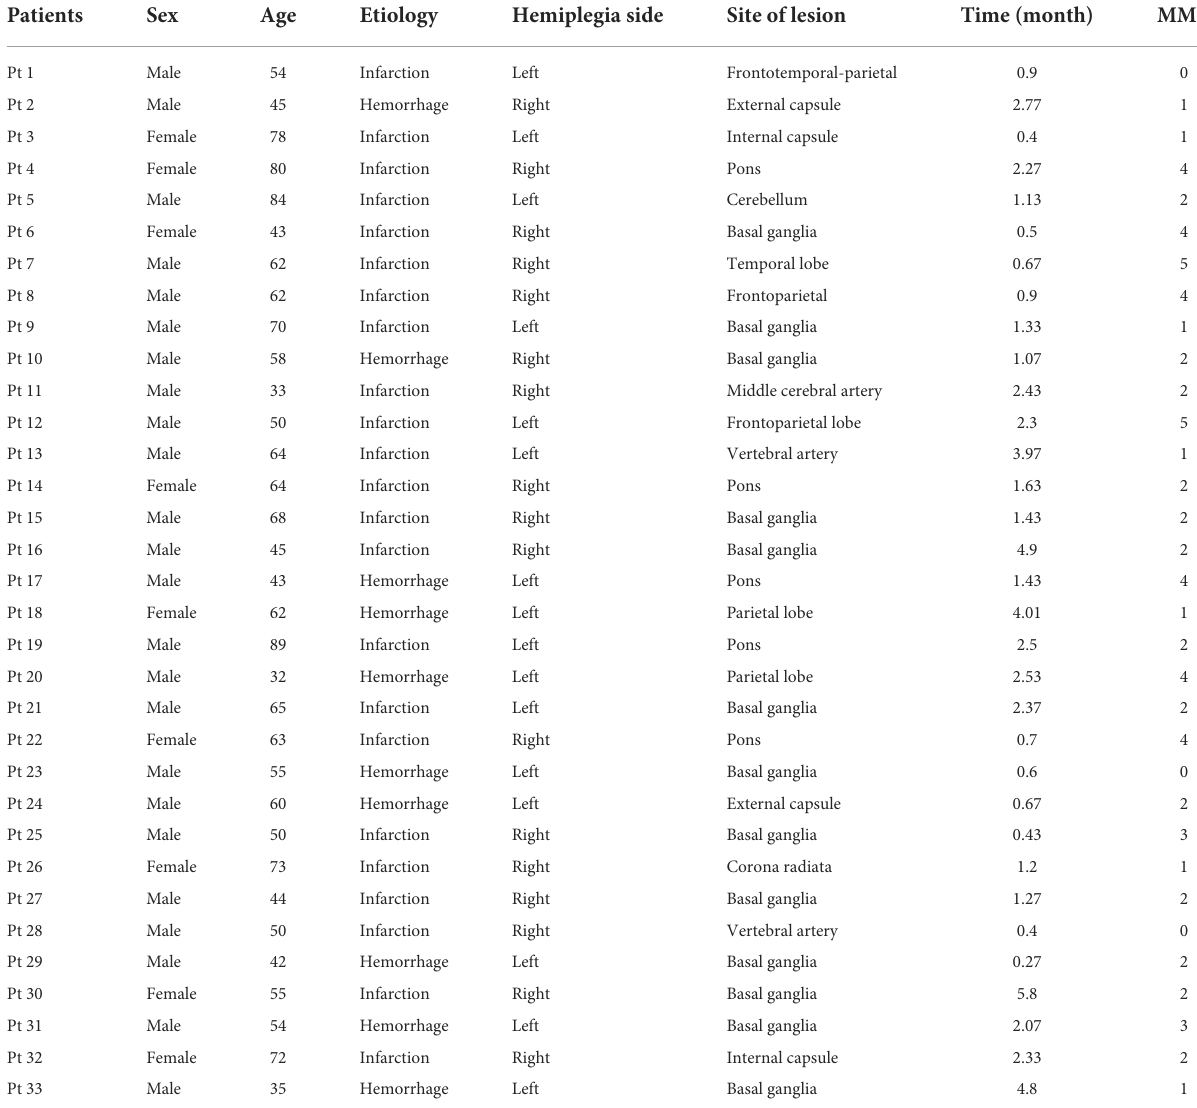
TABLE 1 Characteristics of participants with UL motor